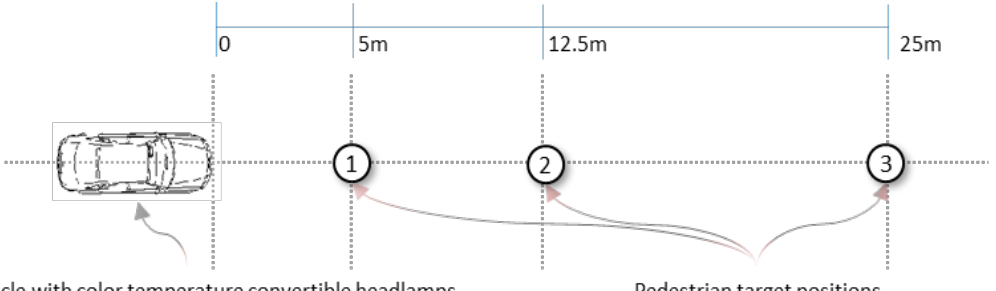
Figure 5. Pedestrian type reflectors as pedestrian targets: Pedestrian target design (height 175 cm, width 92 cm, with four wheels attached below for convenience of movement.